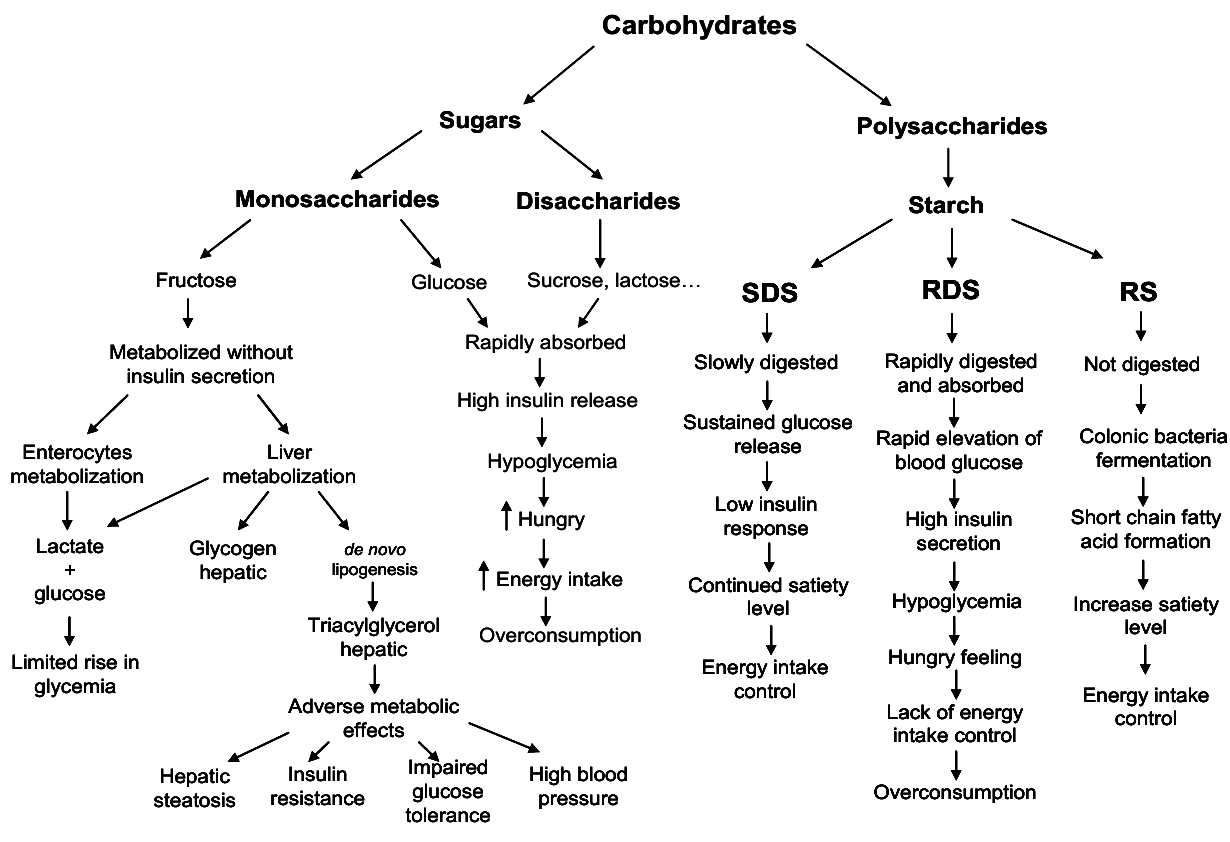
Figure 1. Carbohydrate classification and their main postprandial effects. SDS: slowly digestible starch; RDS: rapid digestible starch; RS: resistant